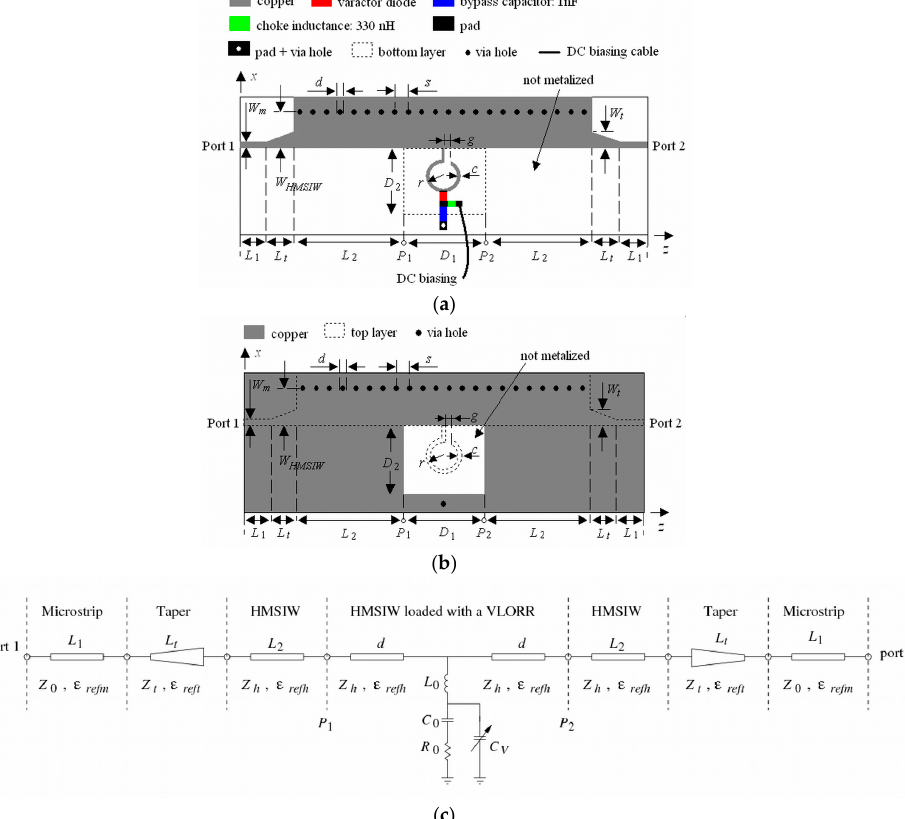
Figure 2. HMSIW loaded with a VLORR ( a ) top structure, ( b ) bottom structure and ( c ) simplified equivalent circuit.